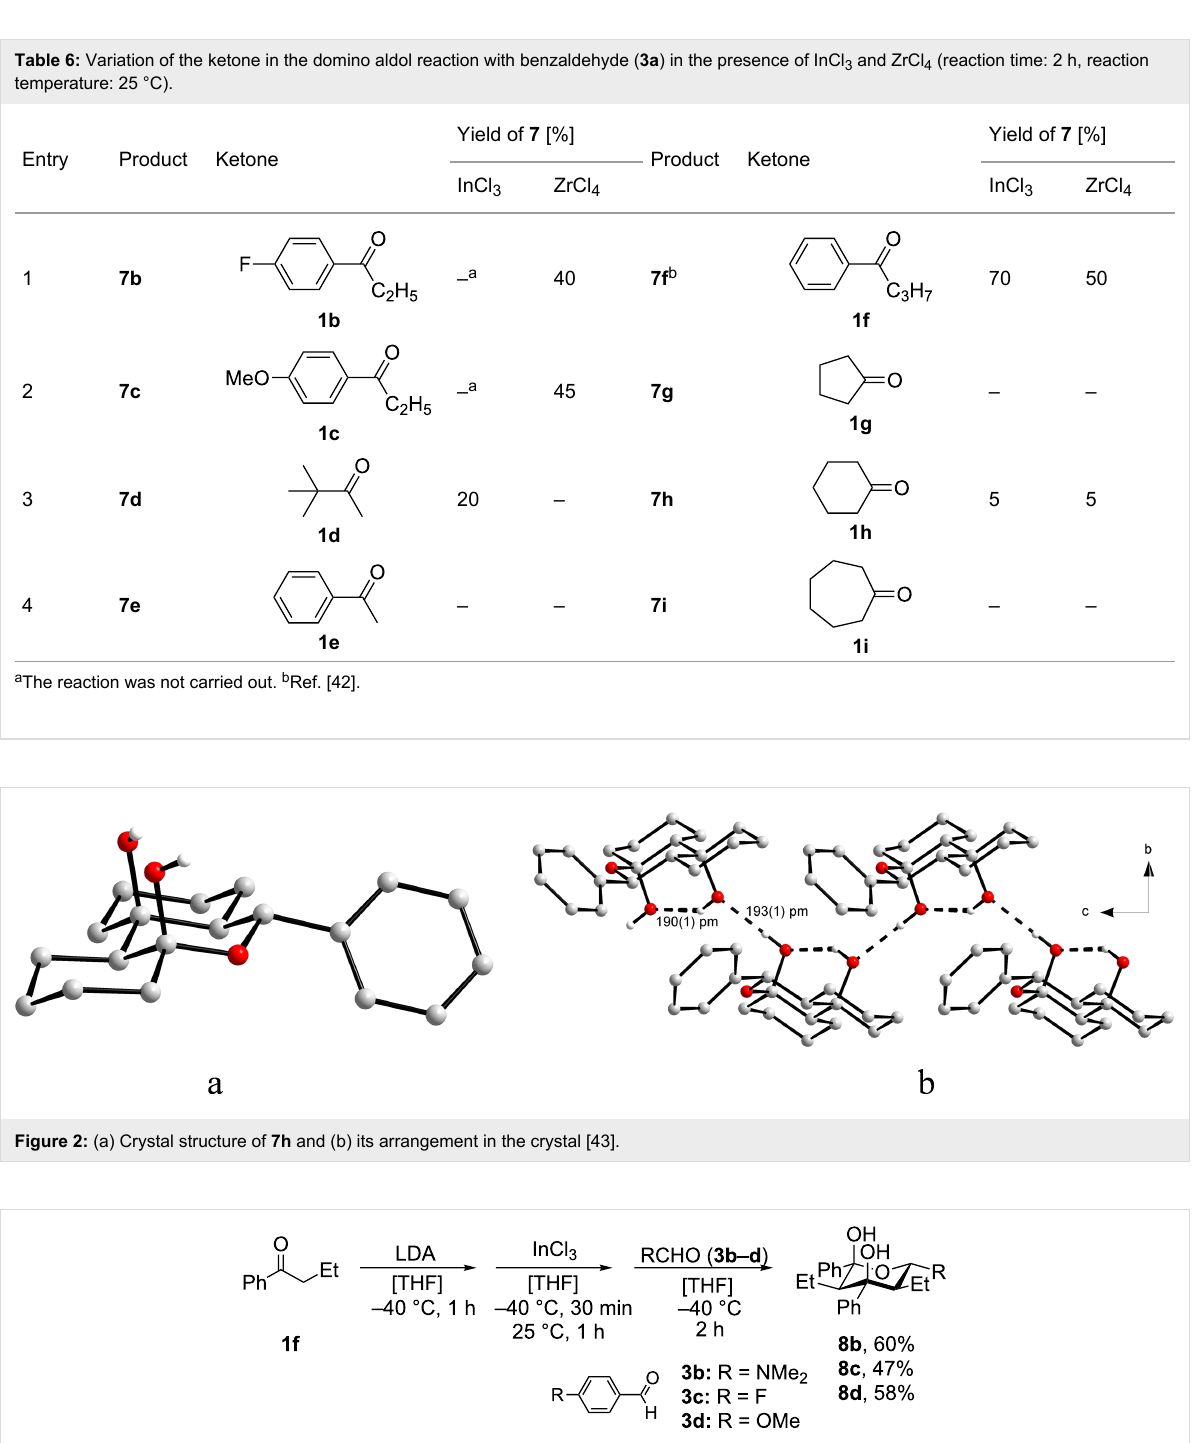
Domino aldol reaction by using a